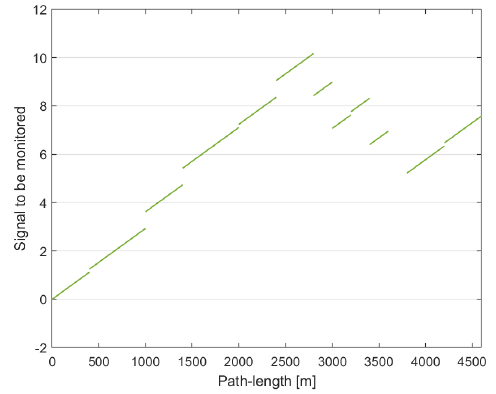
Dt Res g  for the considered TS sequence. For the given sequence and for the Figure 4. Function g Dt → Res for the considered TS sequence. For the given sequence and for the given Figure 4. Function l ← l process parameters functions g Dt → Res and h Dt → Res happen to be Dt Res  l ← l ← g  and h Dt Res given process parameters functions happen to be identical. l l